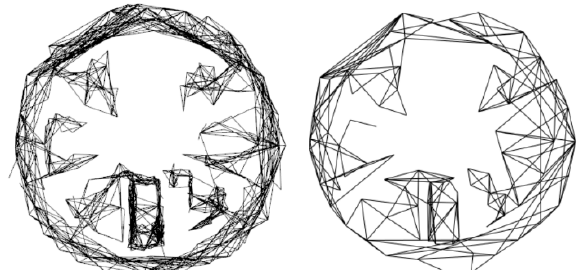
Figure 3: top view of a target-stations 3D sub-network plot (110 stations) with parametric (left) and Gauss-Helmert (right)